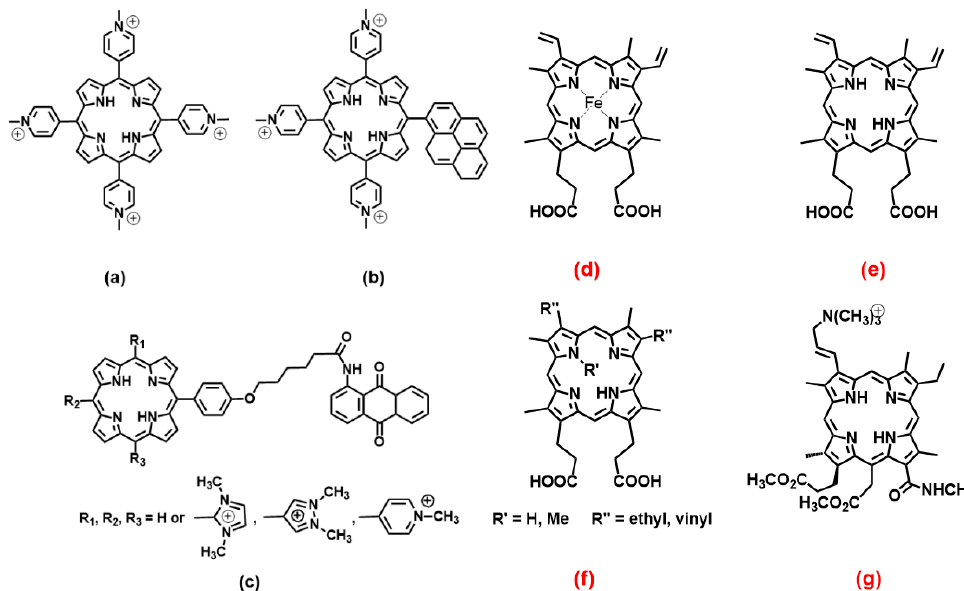
Figure 3. Molecular structures of the selective G4 binders of the porphyrin family reviewed here; ( a ) [42–46,48], ( b ) [49], ( c ) [50], ( d ) [51], ( e ) [52], ( f ) [53] and ( g ) [54]. In this and similar figures, red letters evidence parallel G4s high selectivity, blue letters correspond to molecules selective for antiparallel topology (absent here), and the systems with other/mixed behaviour have black lettering.